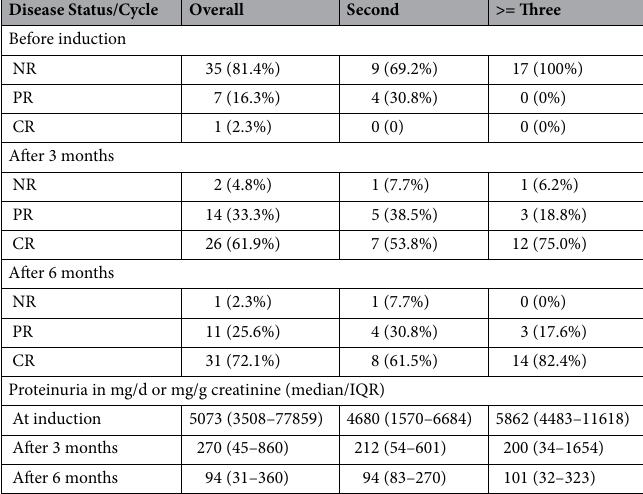
Table 3. Disease status and proteinuria after RTX cycle. CR complete remission, NR nephrotic-range, PR partial